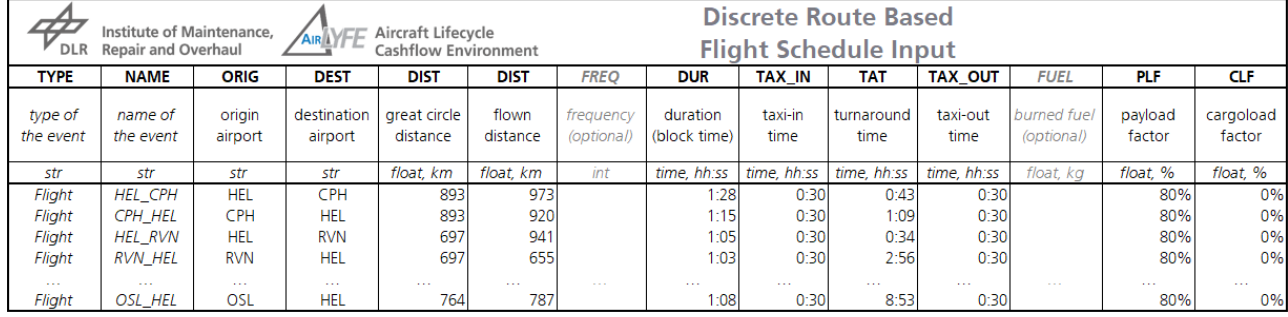
Figure A1. Excerpt of LYFE’s Excel-based input mask for discrete flight operations.